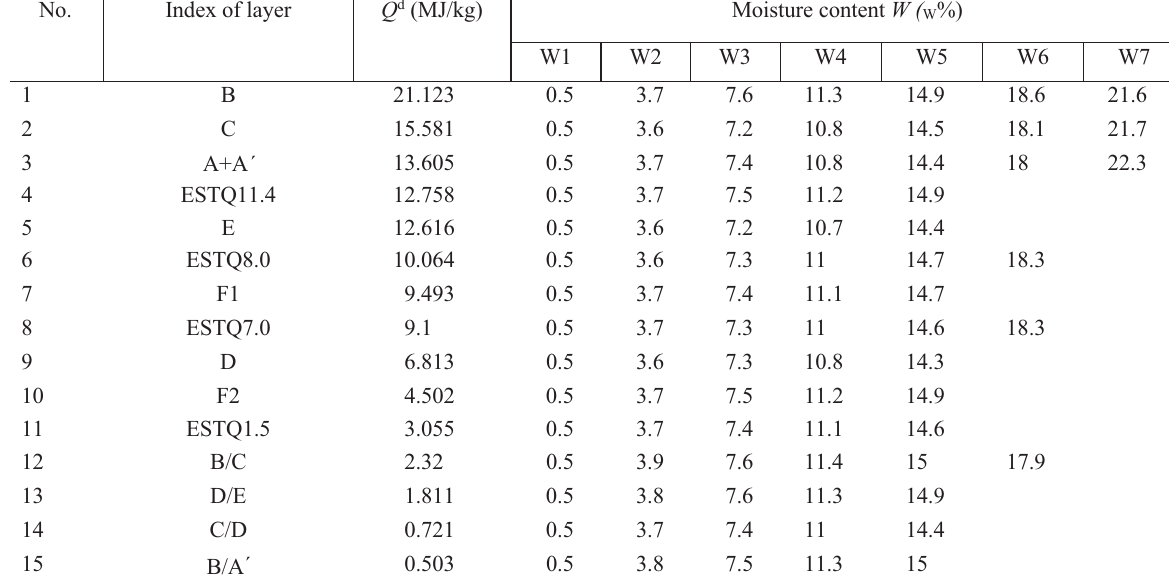
Table 1. Calorific value and moisture content of